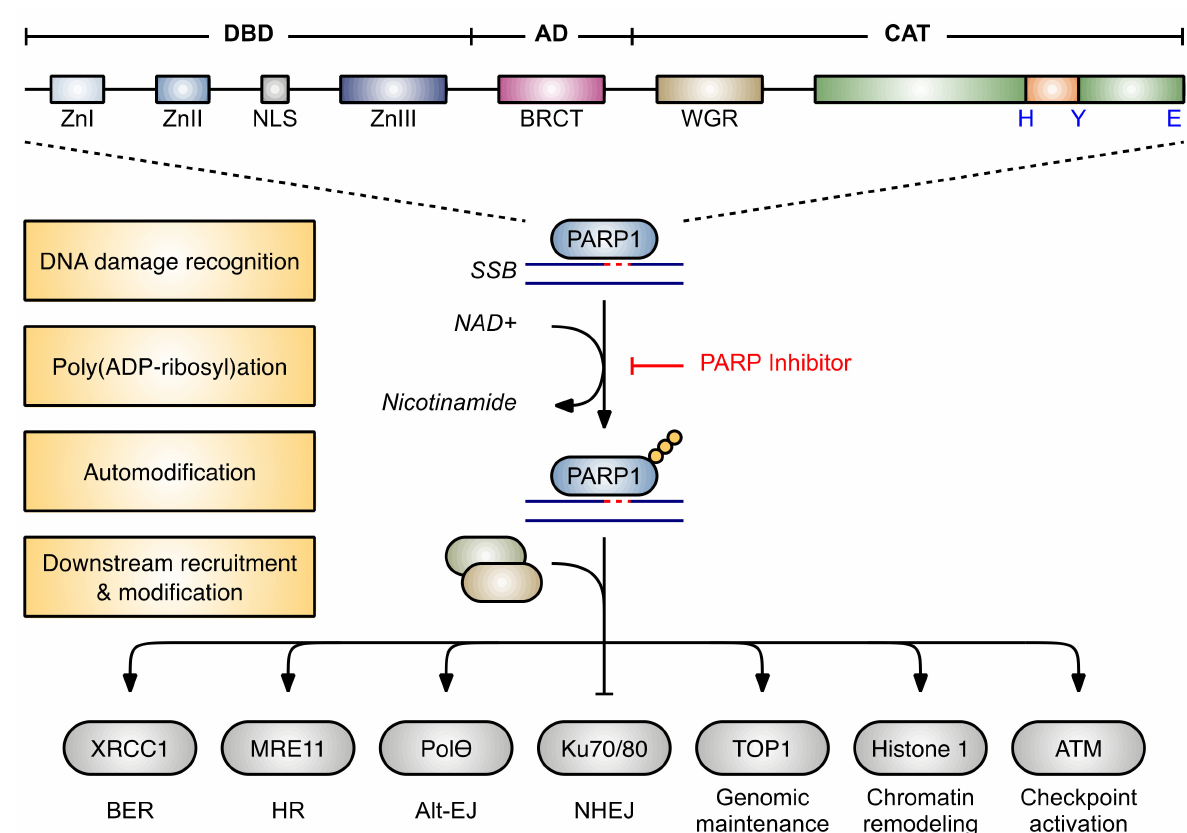
Figure 1. Structure and Function of PARP1. PARP1 comprises a DNA-binding domain (DBD), automodification domain (AD), and catalytic domain (CAT). The DBD contains three zinc finger motifs (Zn) that recognize sites of DNA damage. A nuclear localization signal (NLS) retains PARP1 within the nucleus. The AD contains a BRCA1 carboxy-terminal (BRCT) domain that enables the recruitment and scaffolding of downstream proteins. The CAT houses a Trp-Gly-Arg (WGR) motif that stabilizes DNA binding as well as the His-Tyr-Glu (HYE) catalytic triad. Once bound to DNA, a conformational change activates the CAT to catalyze the poly(ADP)-ribosylation (PARylation) of PARP1 within the AD. PARylation proceeds by transferring ADP-ribose moieties from nicotinamide adenine dinucleotide (NAD + ) to the acceptor polypeptide. The resulting pADPr chains recruit other DNA repair proteins; and PARylation of addition protein substrates helps elicit a variety of actions related to DNA repair, genomic maintenance, transcription, and cell cycle progression. Abbreviations: TOP1, DNA topoisomerase I; BER, base excision repair; HR, homologous recombination; Alt-EJ, alternative end-joining; NHEJ, non-homologous end-joining. Figure adapted from Rouleau, M. et al.